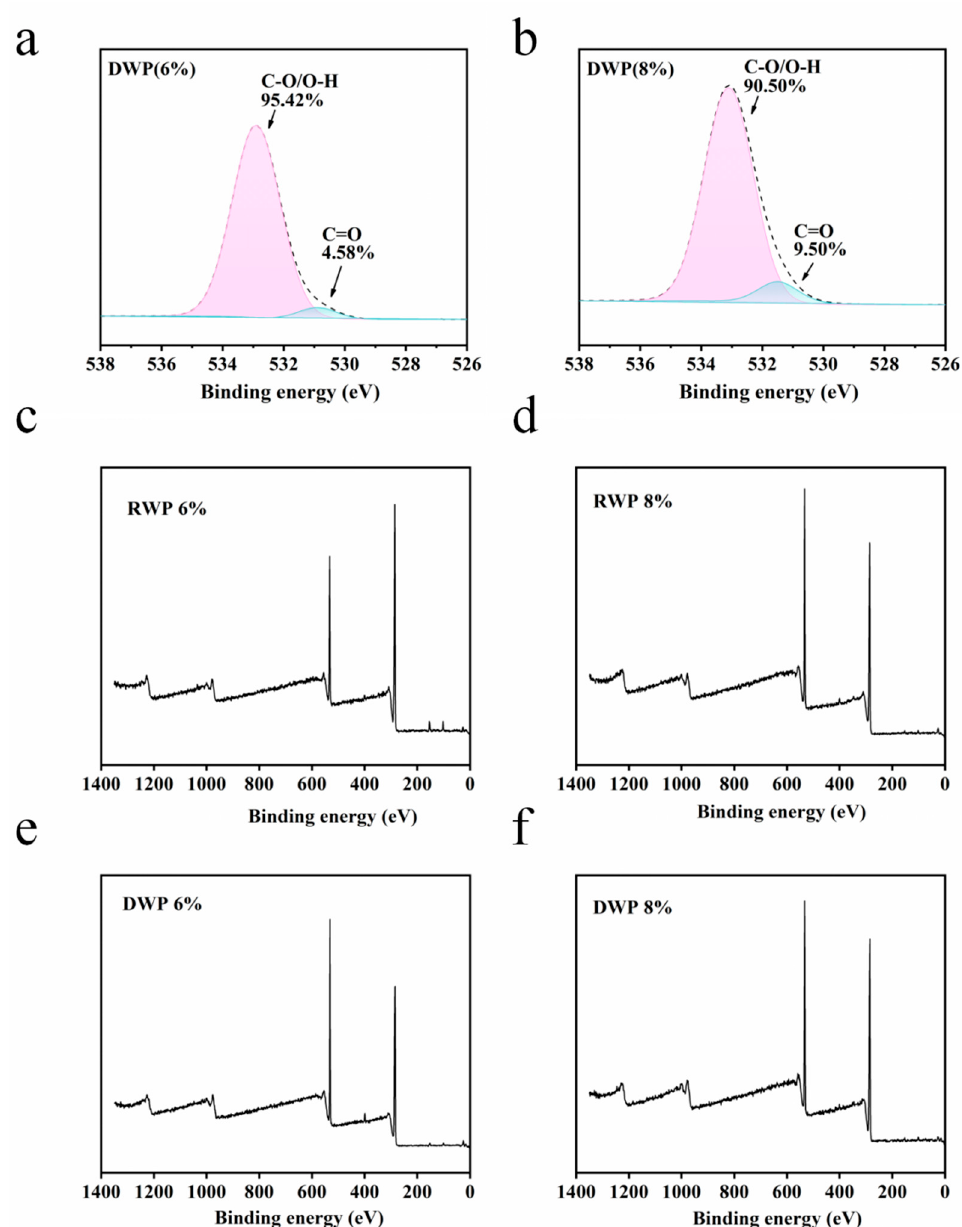
Figure 6. ( a,b ) XPS oxygen fractionation results analysis; ( c – f ) XPS carbon peak results analysis.